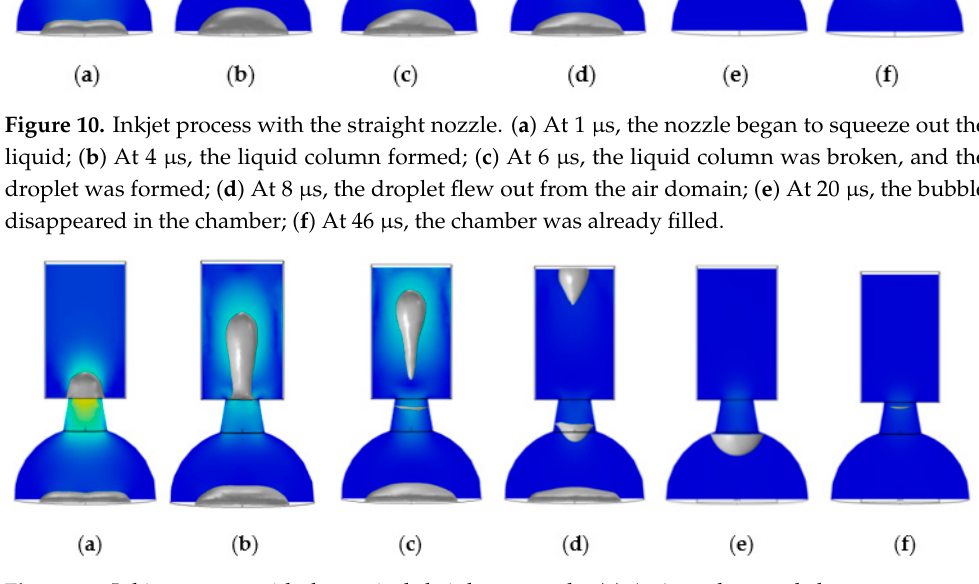
Figure 11. Inkjet process with the conical shrinkage nozzle. ( a ) At 1 µs, the nozzle began to squeeze out the liquid; ( b ) At 3 µs, the liquid column formed; ( c ) At 4 µs, the liquid column was broken, and the droplet was formed; ( d ) At 7 µs, the droplet flew out from the air domain; ( e ) At 15 µs, the bubble disappeared in the chamber; ( f ) At 33 µs, the chamber was filled already.